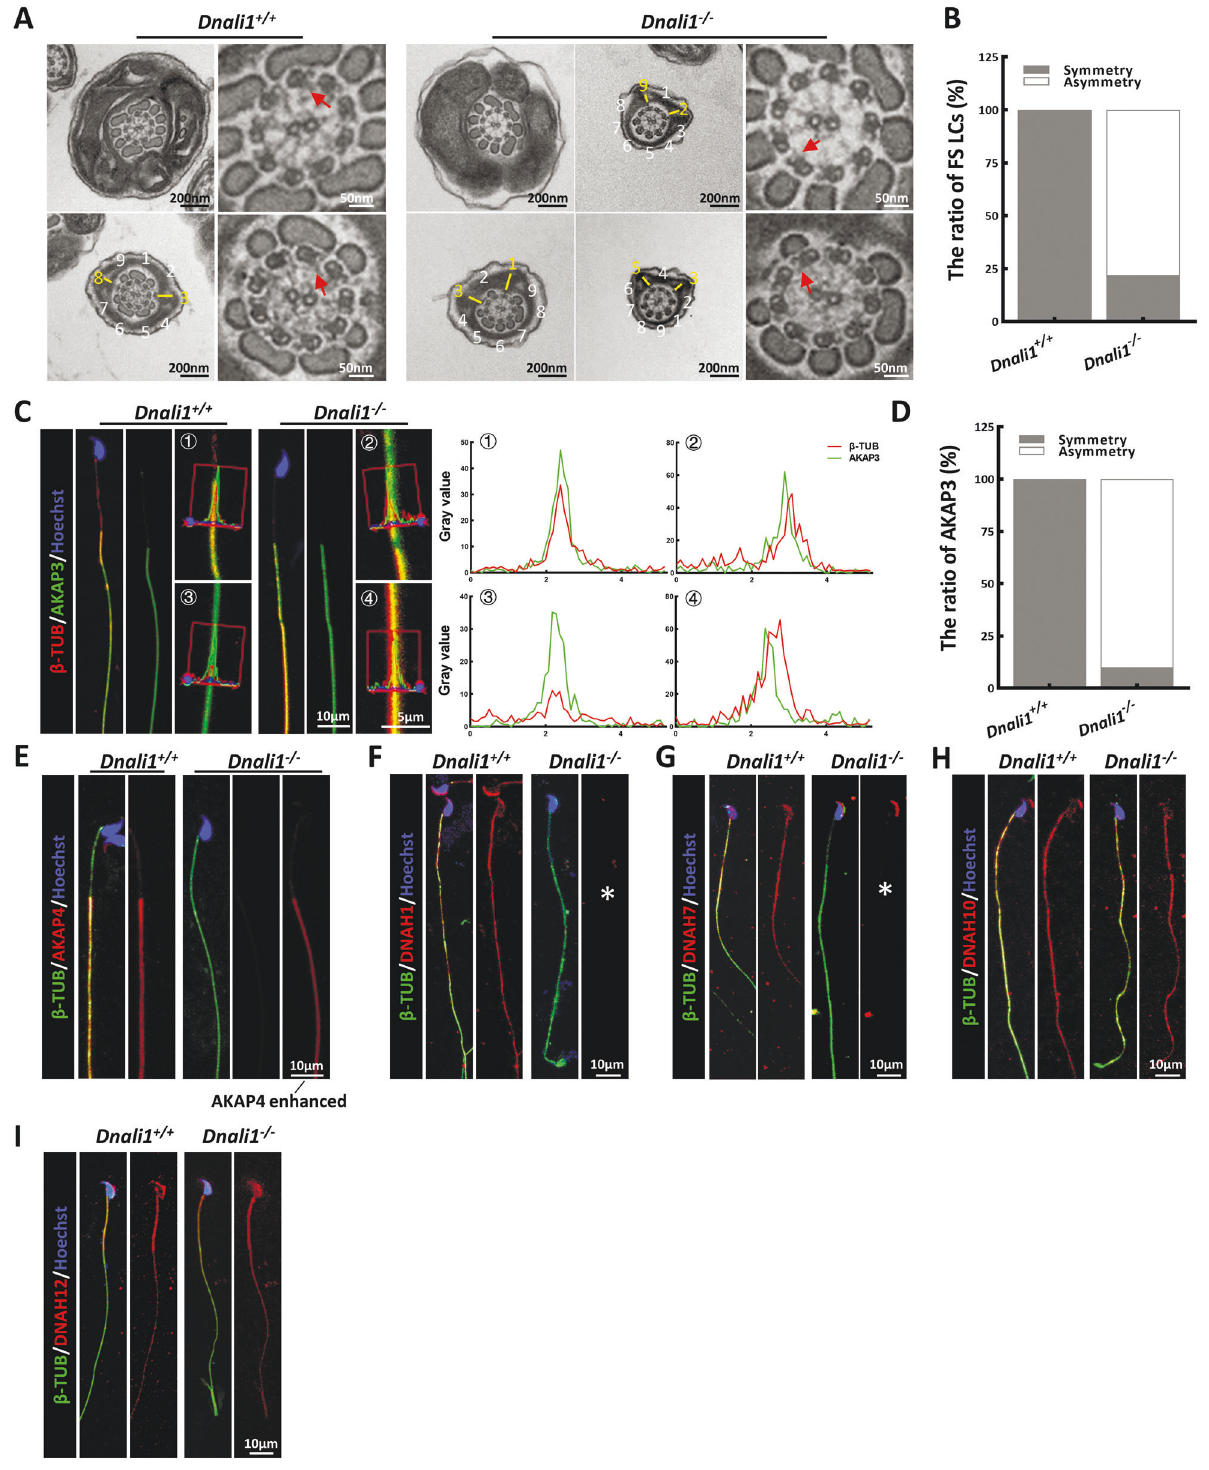
Fig. 4 The LCs position of the Dnali1 − / − spermatozoa is asymmetrical and the IDA components are incomplete. A and B The fl agellar cross-sectional structure of Dnali1 + / + and Dnali1 − / − , as evidenced by TEM. The red arrow indicates an obvious IDA. The numbers represent the quantity of peripheral microtubules. A yellow dash marks the LCs, which are diagonally positioned in the Dnali1 + / + spermatozoa. C The co- staining and the co-localization analysis of AKAP3 and β TUBULIN ( β -TUB). The red lines indicate the area where the fl uorescence intensity are measured. D Quantitative co-localization analysis of AKAP3 and β -TUB. E IF staining against AKAP4. F – I IF staining depicting the locations of each DNAH proteins in the Dnali1 + / + and Dnali1 − / − mice. The asterisks indicate the miss of DNAH1 and DNAH7, respectively.